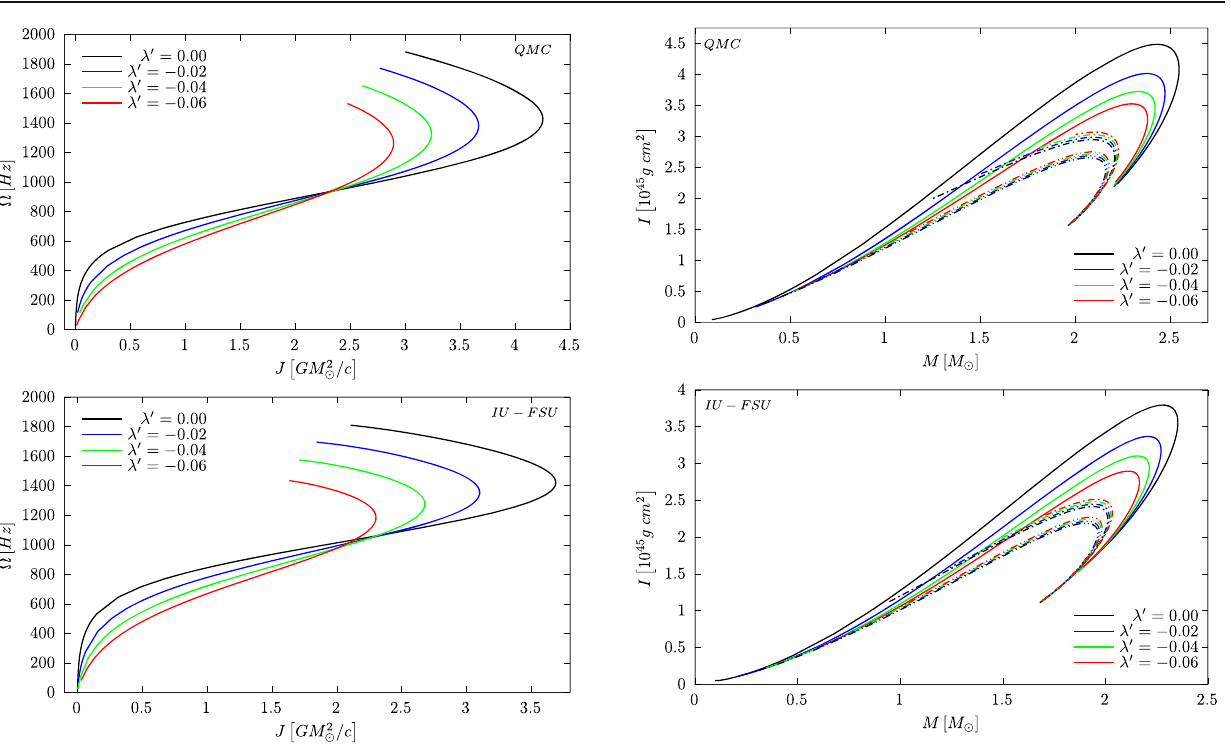
Fig. 4 The angular velocity as a function of the angular momentum for sequences of stars rotating at the mass-shedding limit. The curves for λ (cid:6) = 0 correspond to the GR case